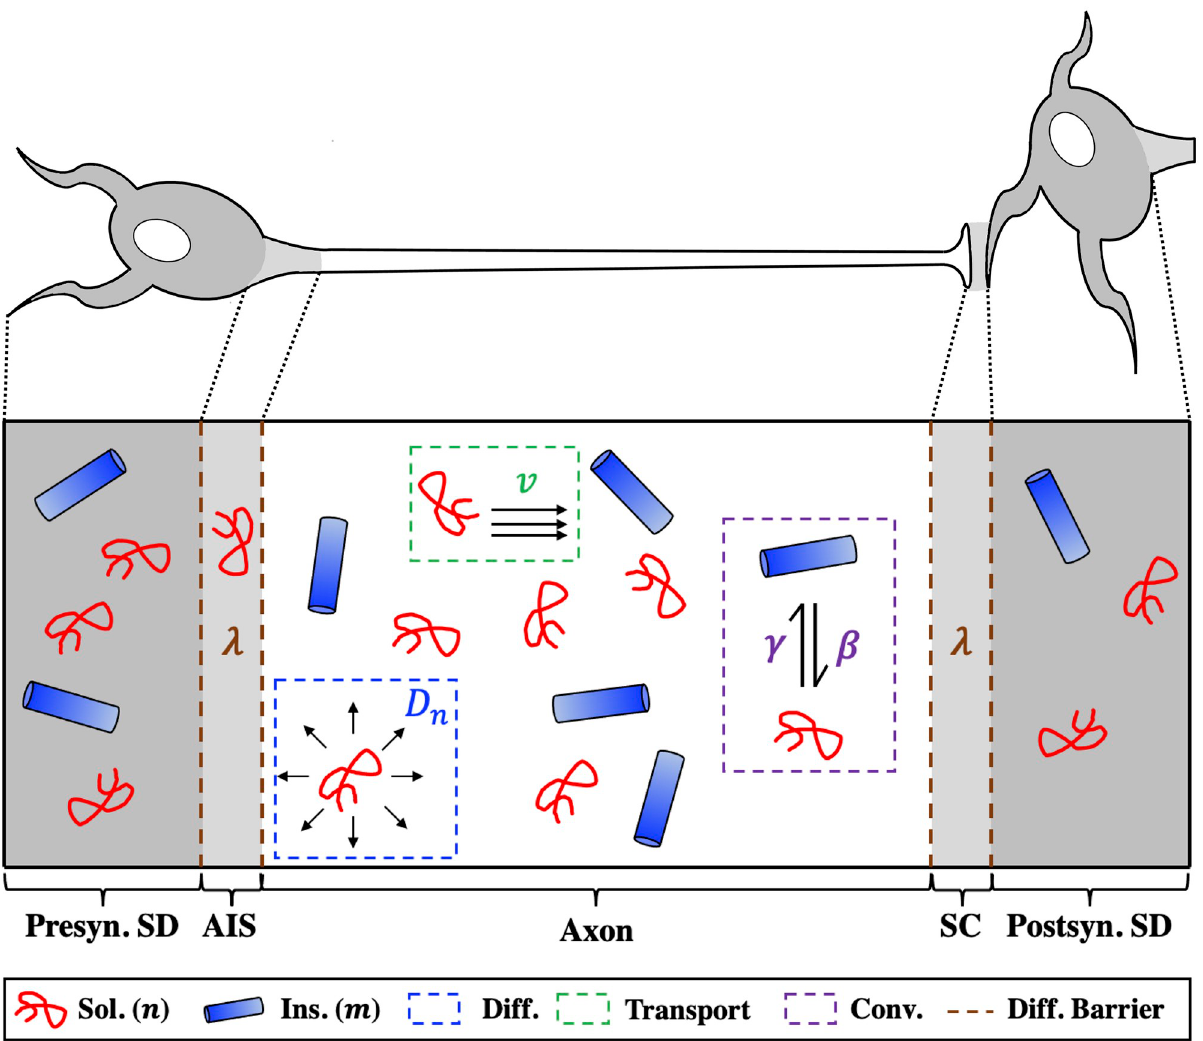
Fig 1. Model System. Schematized version of the one-dimensional system that we simulate. We model two distinct species of pathological tau, soluble (red) and insoluble (blue), across within a multi-compartment model mimicking the two-neuron system shown in the top panel. The main biological phenomena captured in this model are diffusion (blue box), active transport (green box), species interconversion through fragmentation and aggregation (purple box), and a diffusion-based barrier to inter-compartmental spread (brown dashed